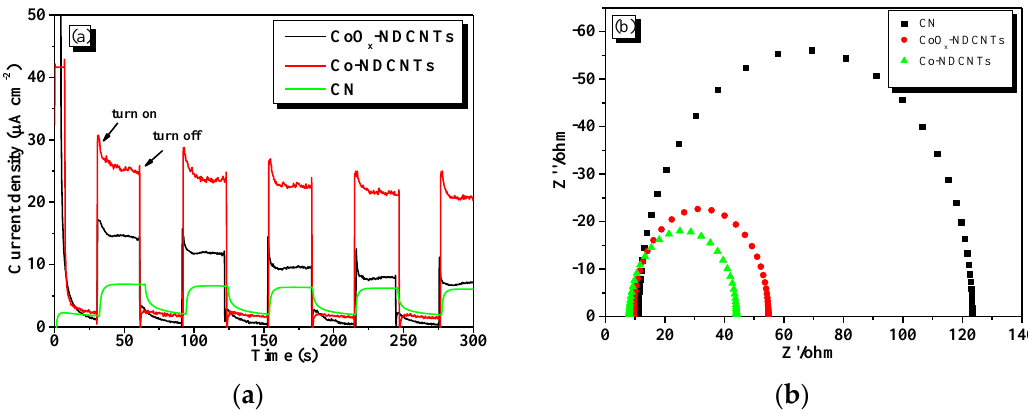
Figure 6. ( a ) The transient photocurrent response under visible light irradiation and ( b ) electrochemical